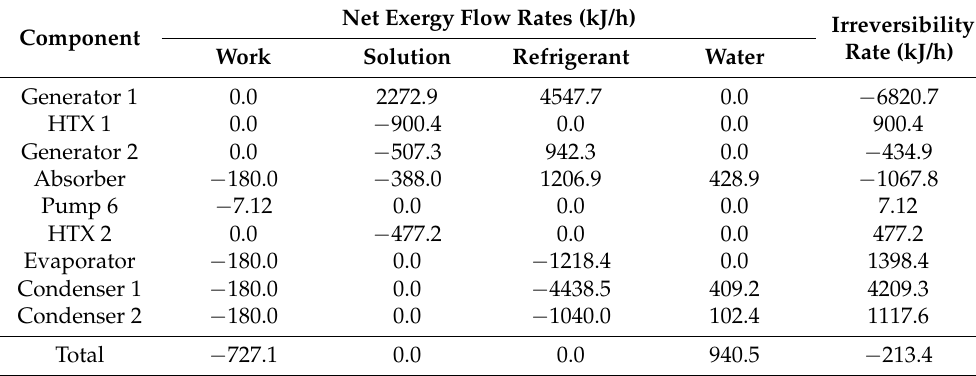
Table 12. Exergy balance for each component in industrial double-effect LiBr–water absorption refrigeration system shown in Figure 2 (Cooling capacity is 6.0